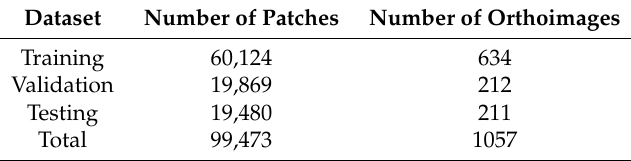
Table 1. Description of the training, validation and test sets of the poles dataset. Dataset Number of Patches Number of Orthoimages